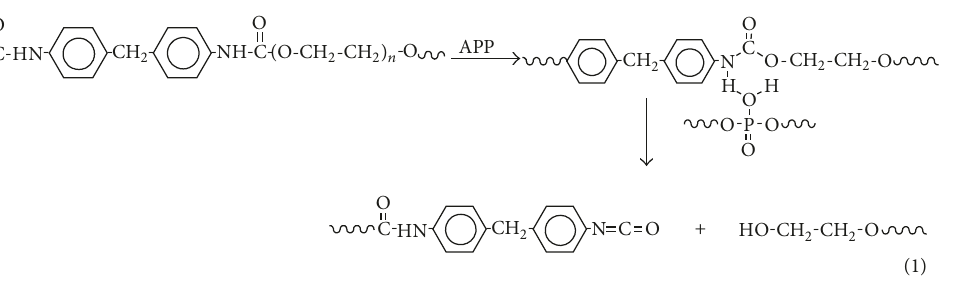
Figure 2: The catalytic reaction of APP and PU.